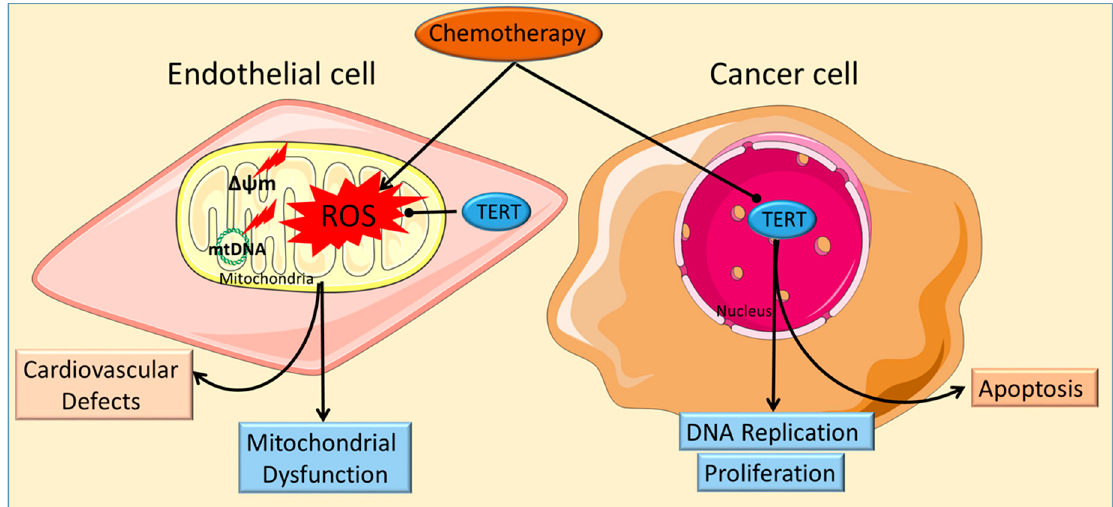
Figure 1. Differing role of telomerase within chemotherapeutic induced cellular damage (endothelial/cancer cells) and interconnectedness with cardiovascular disease. Cancer cells are the primary targets of a wide array of chemotherapeutic agents and often contribute to the forced apoptosis of cancerous cells. Separate from its emerging role as a protective element in the mitochondria, TERT functions to regulate DNA replication and proliferation in the nucleus.